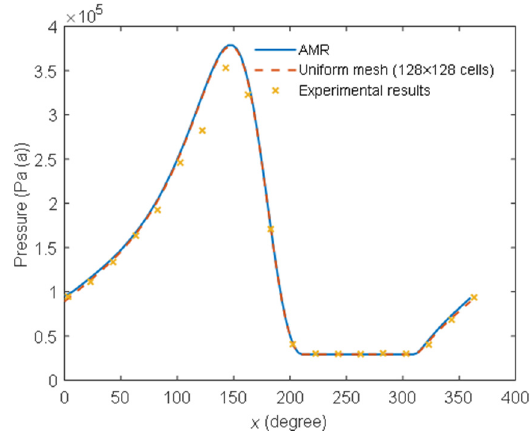
Figure 9. Final refined mesh for journal bearing: ( a ) pressure distribution; ( b ) density ratio distribution.